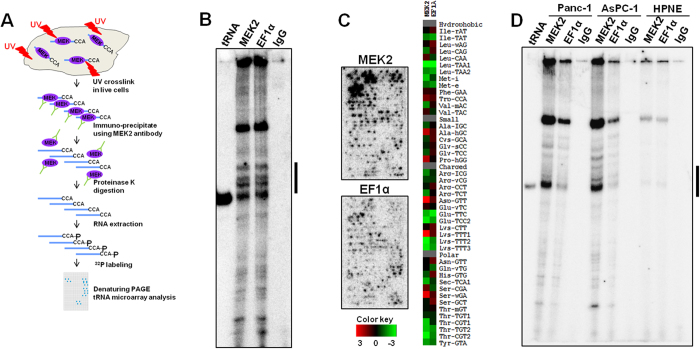
tRNA and MEK2 interaction in pancreatic cancer cells and in a non-tumorigenic cell line.(A) Flow chart of CLIP-Chip. Cells growing on tissue culture plastic were exposed to UV to crosslink RNA and proteins in live cells and then processed for CLIP-Chip using specific antibody against MEK2. (B) Denaturing PAGE analysis was performed to evaluate MEK2-tRNA interaction in CD18 pancreatic cancer cells. EF1α antibody was used as a positive control, and IgG as a negative control. The indicated tRNA bands were cut out for tRNA microarray. (C) tRNA microarrays for semi-quantitative analysis of CLIP-Chip array results, and representative arrays are shown. Anticodon specific tRNA signals are calculated and expressed as log2(X), where X indicates values relative to the median value of each array. Relative abundance of specific tRNAs are shown as heat map and are indicated with colors ranging from green (low) to red (high). (D) PAGE analysis was performed to evaluate crosslinked tRNAs to MEK2 and EF1α in Panc-1 and AsPC-1 pancreatic cancer cells, and in the non-tumorigenic pancreatic cancer cell line HPNE.